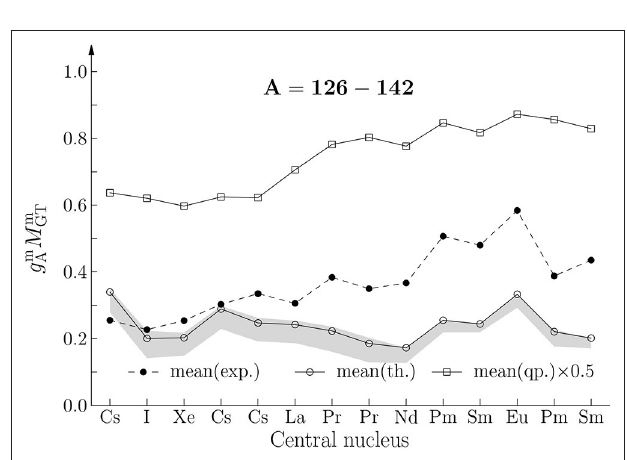
FIGURE 6 | The same as in Figure 5 for the mass range A